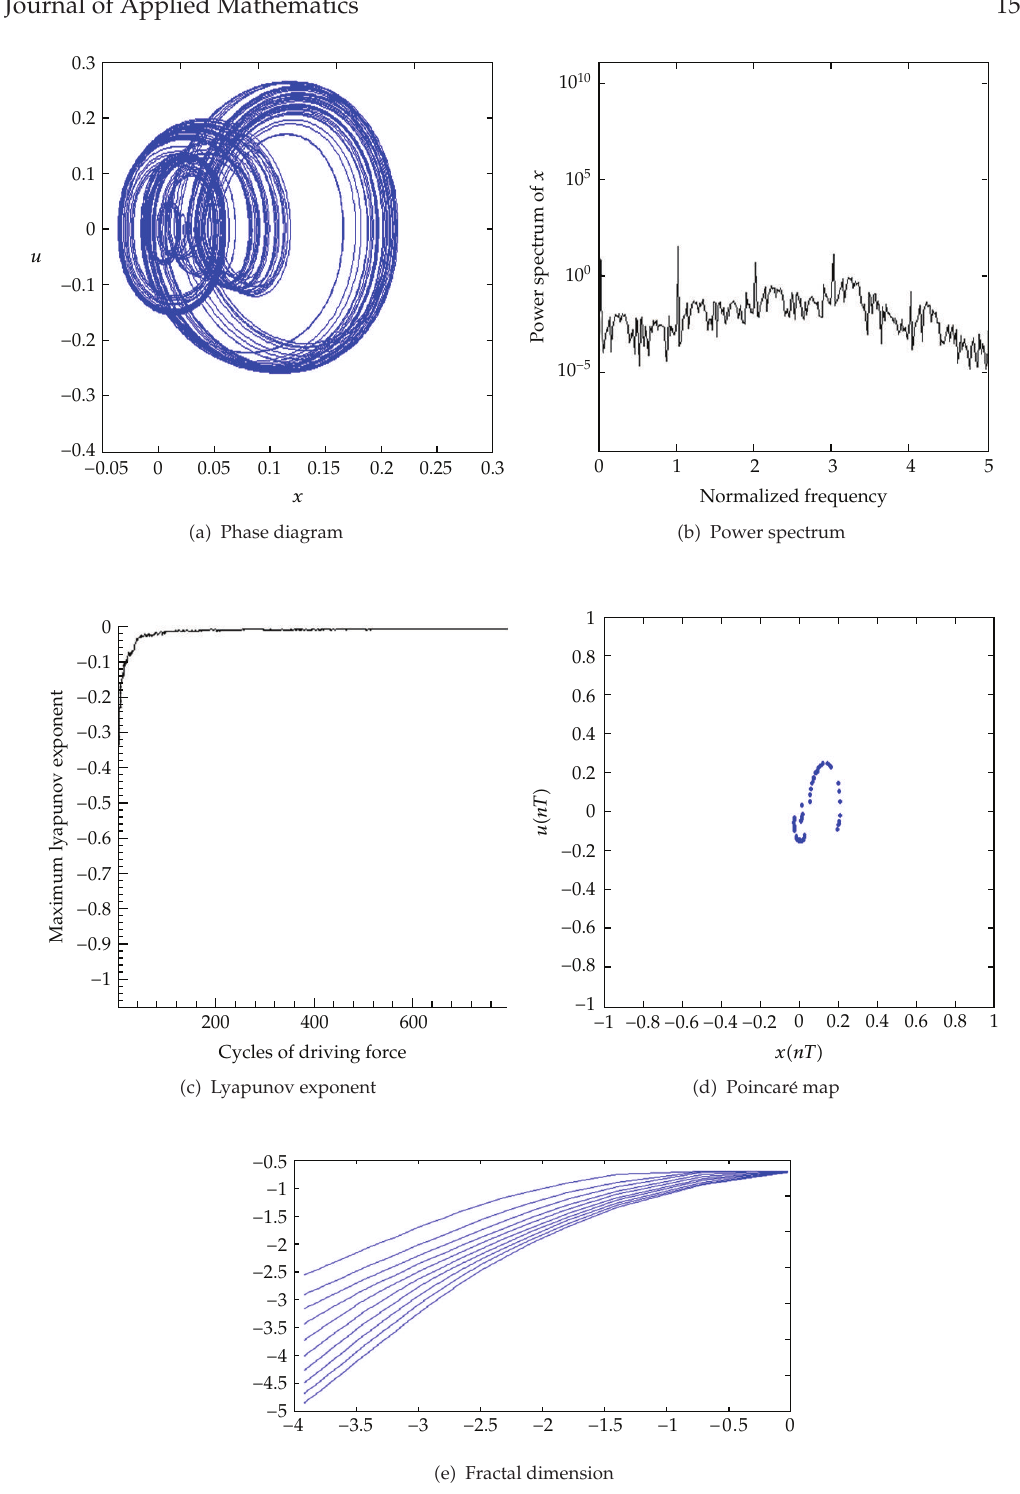
Figure 9: Simulation results obtained for rotor-bearing system with s (cid:8) 0 . 42 (cid:2) with rub-impact e ff ect (cid:3)